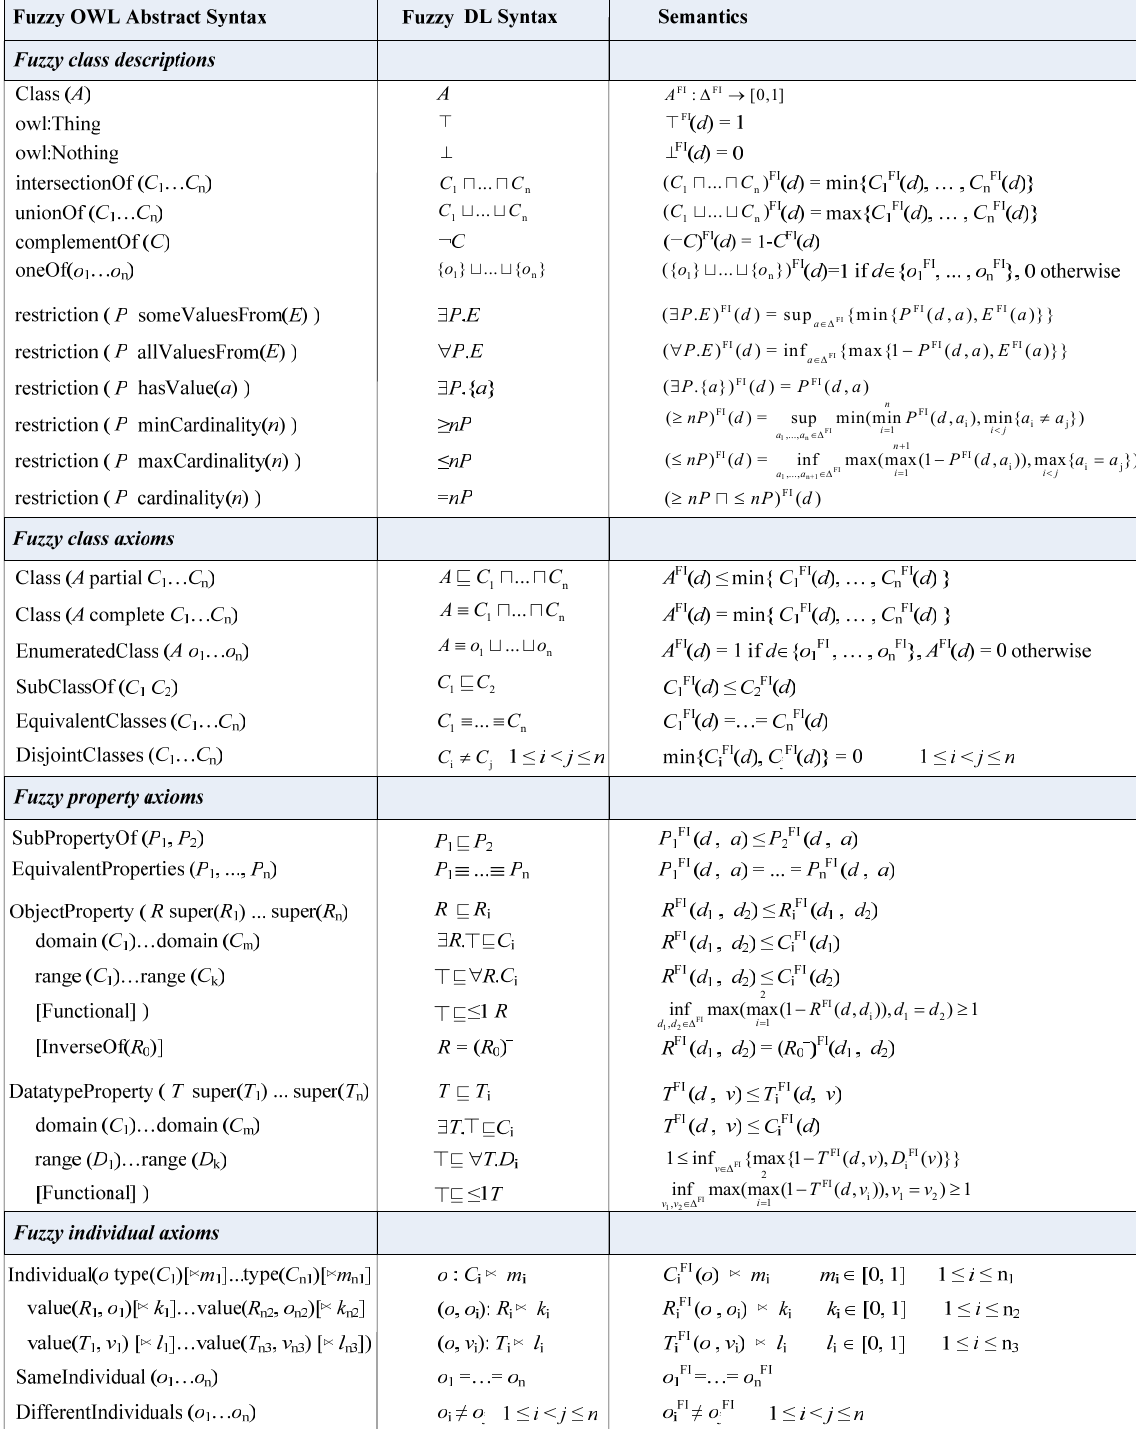
Table 1. Fuzzy OWL abstract syntax, fuzzy Description Logic (DL) syntax, and